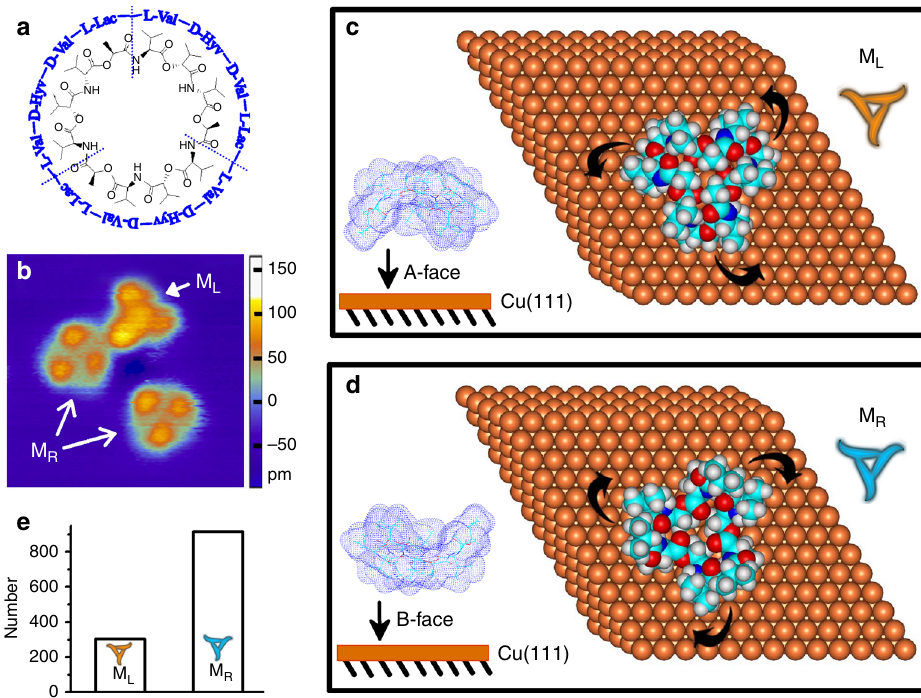
Fig. 1 Individual valinomycin monomer. a Structure formula of valinomycin. b STM image (8 nm × 8 nm) of valinomycin monomers adsorbed on Cu(111) surface at 78 K. M L and M R coexist on the surface. c, d Calculated adsorption con fi gurations of M L and M R . M L and M R were schematically simpli fi ed as yellow counterclockwise propeller and blue clockwise propeller in the top right corners, respectively. Side views of simulated molecular model of valinomycin packed with electron density deposited onto the Cu(111) surface were inserted in the bottom left corners. In calculated molecular models, copper, carbon, nitrogen, oxygen, and hydrogen atoms were displayed in brass, cyan, blue, red, and gray, respectively. e Statistic molecular numbers of M L and M